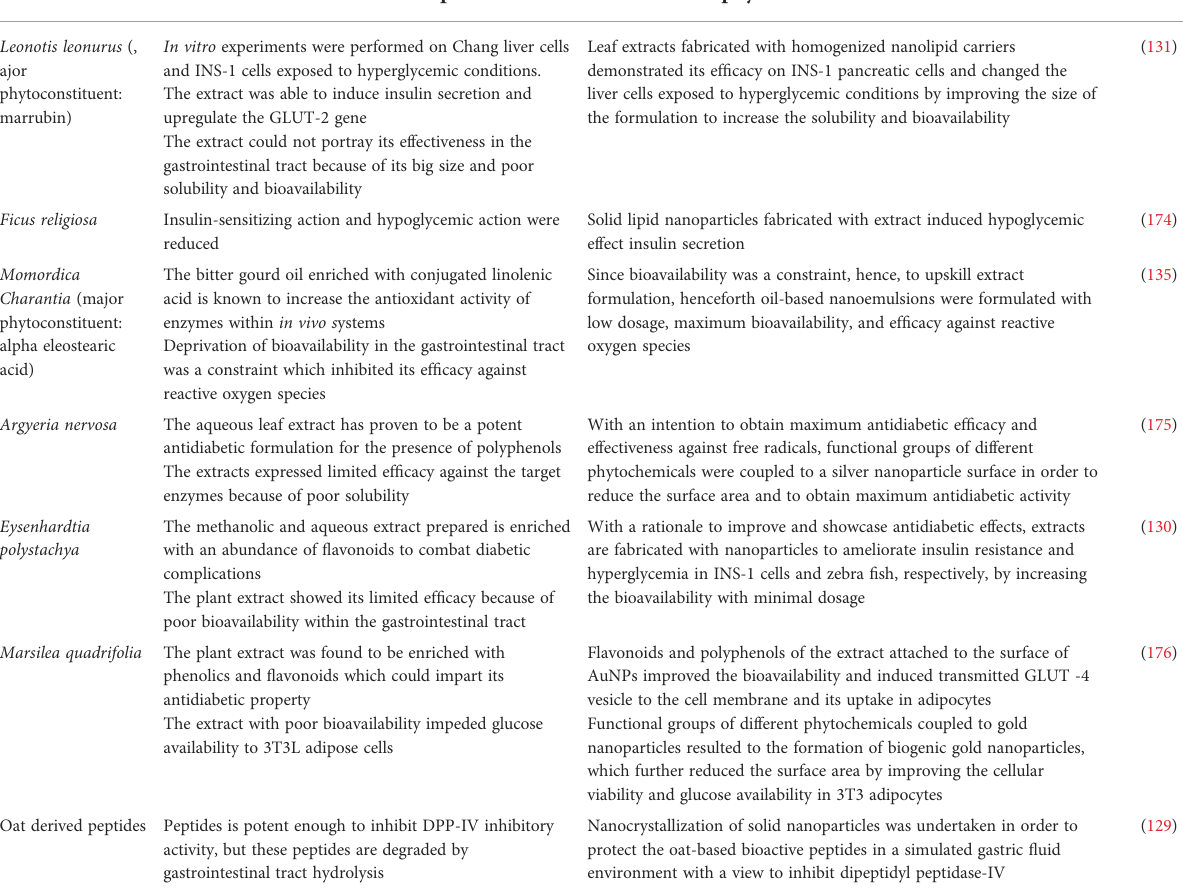
TABLE 4 Different marketed polyherbal drugs with their composition and mechanism of action as dipeptidyl peptidase-IV inhibitors.